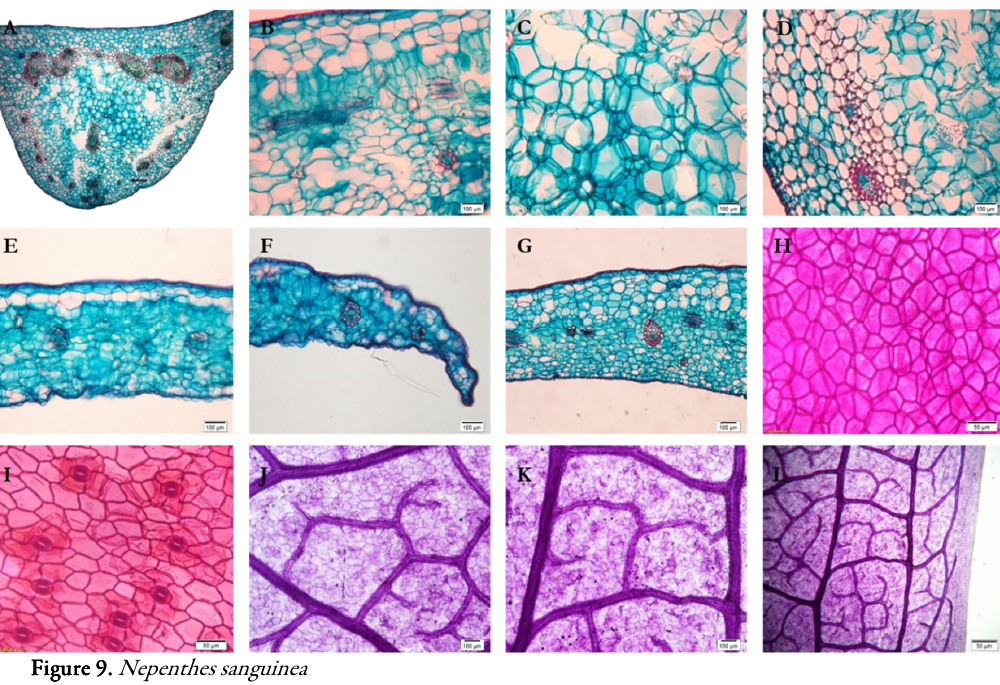
Figure 9. Nepenthes sanguinea (A) Midrib TS. (B) Hypodermis cells, (C) Solitary crystals (D) Solitary crystals (E) Lamina TS. (F) Margin TS (G) Druses, (H) Adaxial epidermis, (I) Abaxial epidermis with stomata observation, (J) Areolar venation, (K) Areolar venation, (L) Marginal venation. Bars A, H, I, L: 50µm; B, C, D, E, F, G, J, K: 100µm. Nepenthes alba (Figure